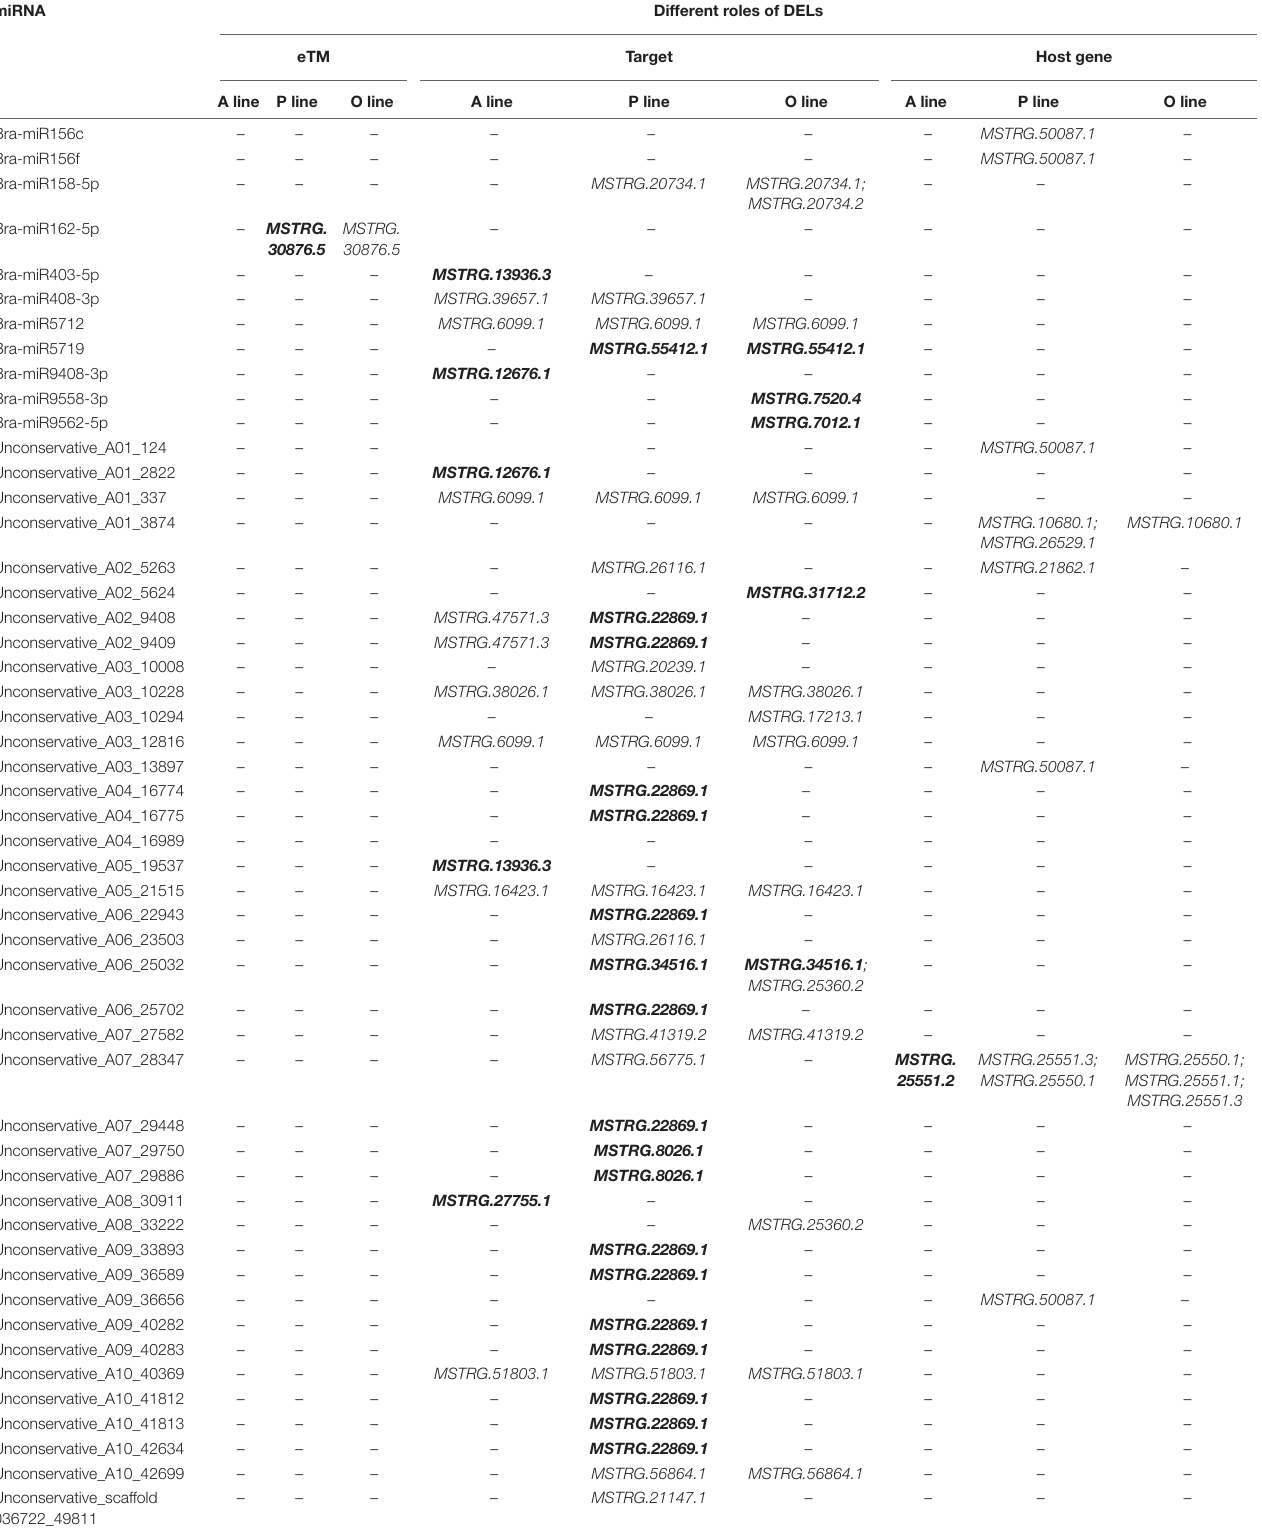
TABLE 3 | Summary of differentially expressed lncRNAs acting as miRNAs’ targets, precursors, and eTMs in Brassica campestris .